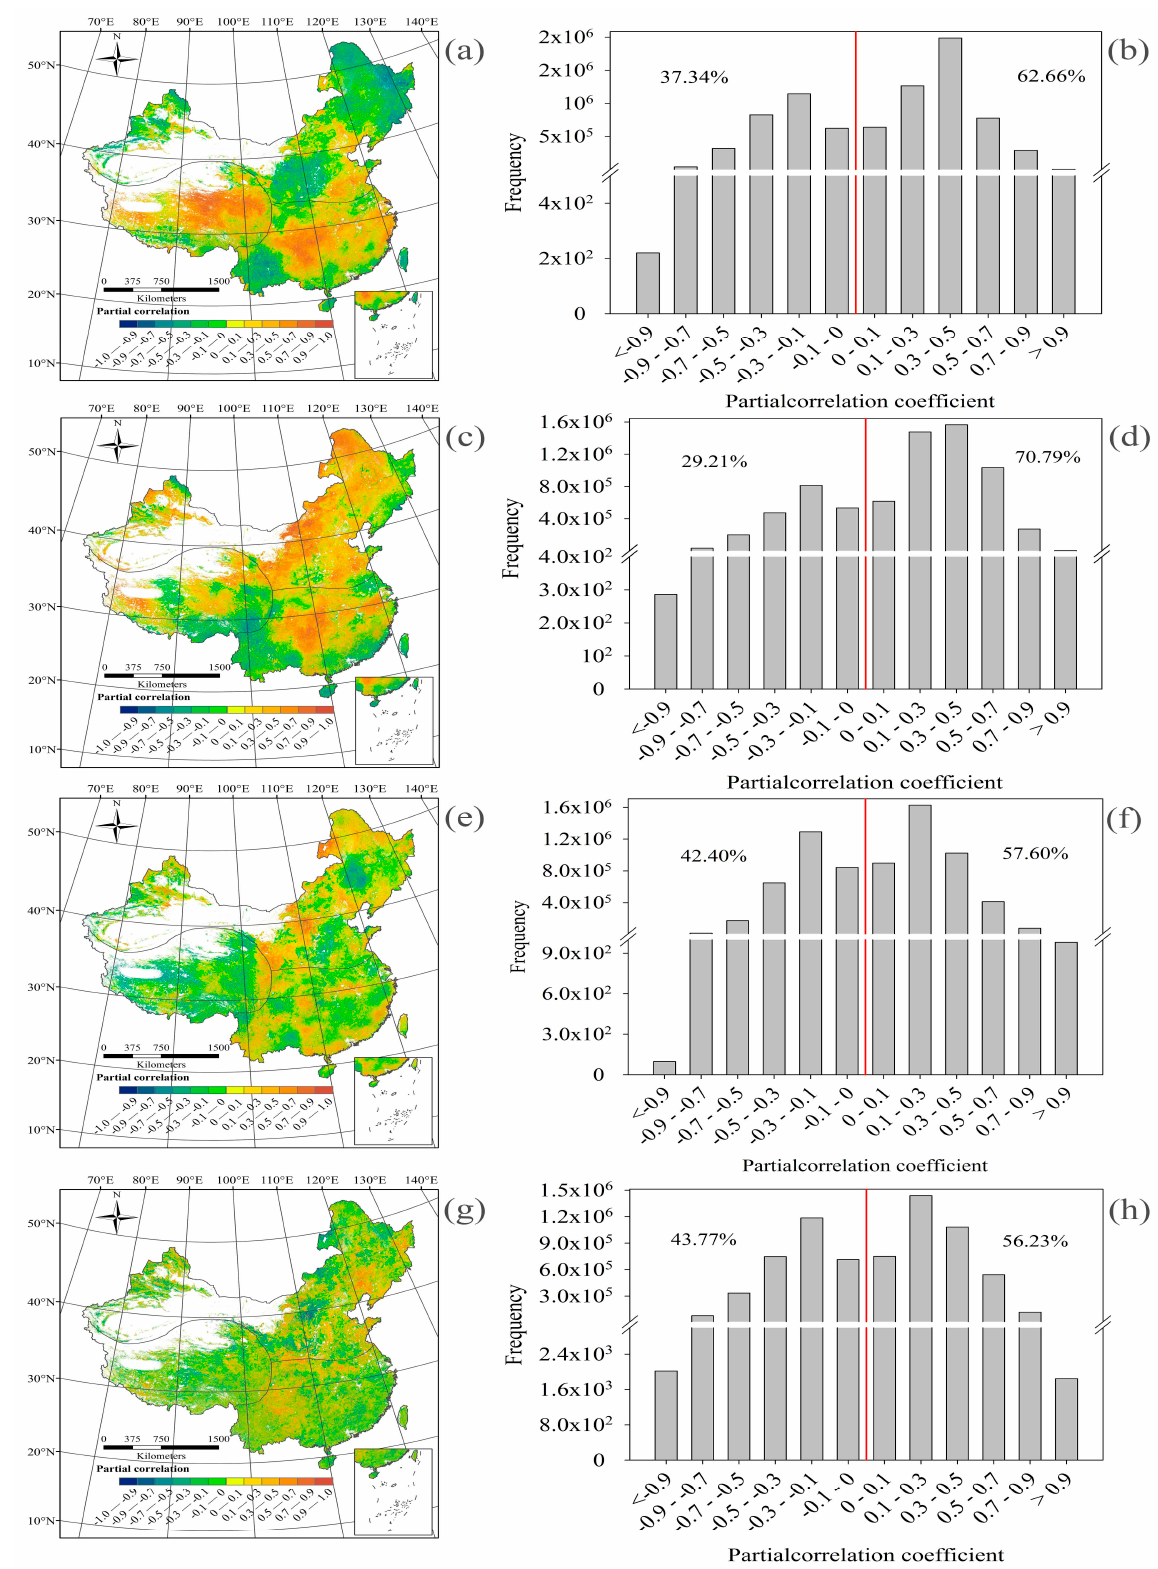
Figure 7. The partial correlation coefficients and corresponding frequency distribution between the NPP and temperature ( a , b ), precipitation ( c , d ), solar radiation ( e , f ) and LOS ( g , h ) in China from 2001 to 2014. The red lines in figures (b), (d), (f) and (h) represent boundary for negative relationship and positive relationship.